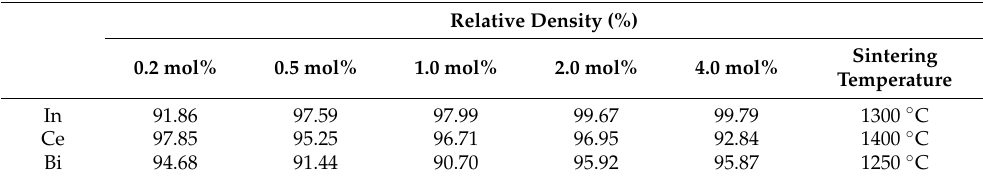
Table 3. Relative density of doped BZN samples sintered at different temperatures. Reprinted with permission from [48], copyright 2011, Elsevier.